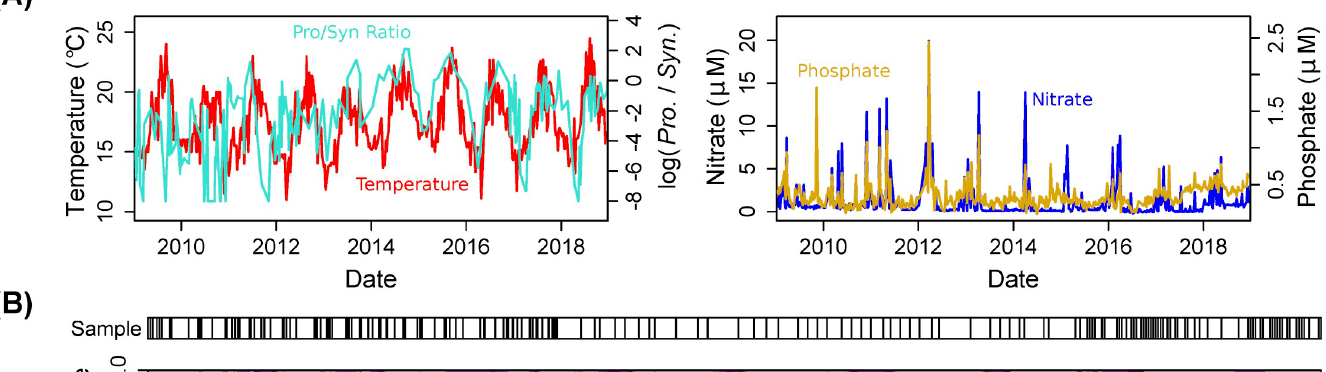
Fig 1. Seasonal and interannual changes in environmental conditions and ecotype frequencies. ( A ) Temperature (˚C), nitrate and phosphate concentrations ( μ M), and the log 10 -transformed ratio of Prochlorococcus sequence counts relative to Synechococcus sequence counts in the MICRO time series. ( B ) Interpolated relative abundance of rpo C1 reads taxonomically assigned to the six most abundant Prochlorococcus (Pro.) and Synechococcus (Syn.) ecotypes. The sampling dates are marked